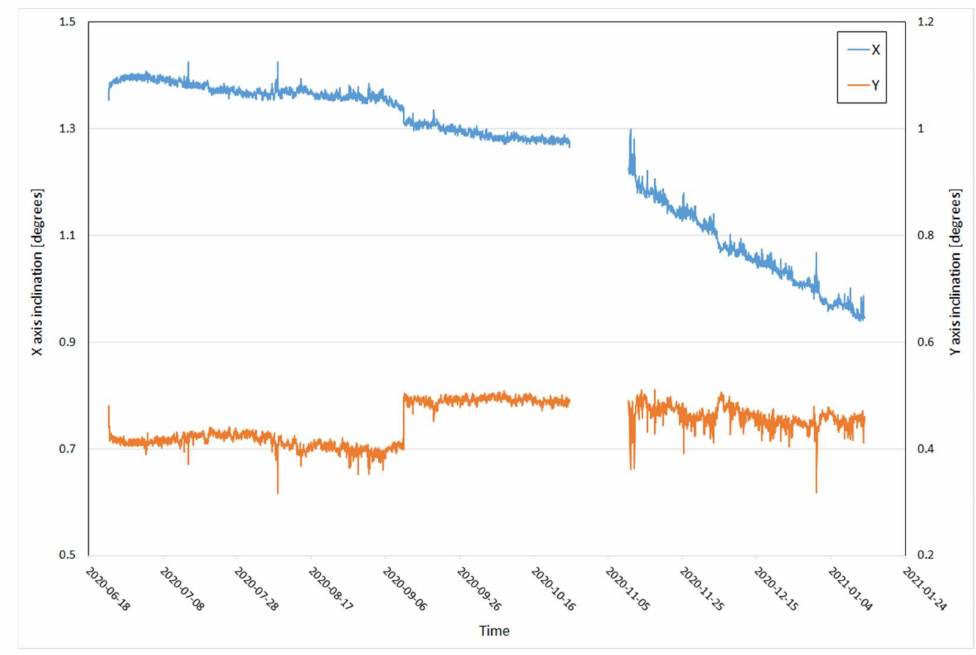
Figure 16. Changes in the slope (X and Y components) recorded by the CNS 220 sensor in the SI-XI/4